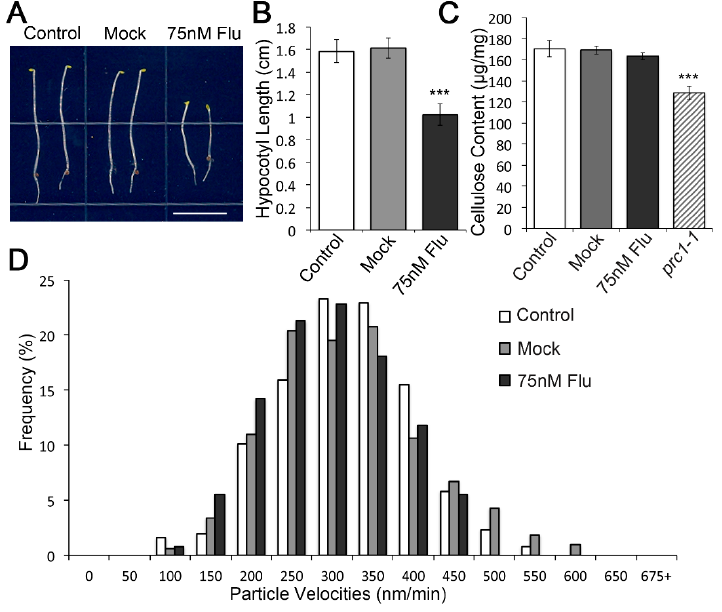
Figure 6. General VLCFA synthesis defect does not influence the functionality of the cellulose synthesis machinery. ( A ) Application of 75 nM Flu reduced the hypocotyl length of etiolated seedlings. 4-day-old dark-grown wild type (Col-0) seedlings grown on 1 / 2 MS medium (Control) or 1 / 2 MS medium containing 75 nM Flu or comparable amount of DMF (Mock). ( B ) Quantification of hypocotyl length of seedlings from the drug treatment analysis. *** p < 0.0001 ( n ≈ 50 per experimental group). ( C ) Crystalline cellulose production was not a ff ected following Flu treatment. Cellulose content of 3-day-old seedlings grown on 1 / 2 MS medium, 1 / 2 MS medium containing 75 nM Flu or comparable amount of DMF. Error bars represent SD. *** p < 0.0001. ( D ) A histogram showing the distribution of GFP-CESA3 particle velocities. The mean velocity of plasma membrane GFP-CESA3 for control, Mock and Flu groups were 319.59 ± 83.93 nm / min ( n = 258, 14 cells from 6 seedlings), 318.21 ± 92.41 nm / min ( n = 328, 16 cells from 7 seedlings) and 295.89 ± 79.00 ( n = 127, 8 cells from 5 seedlings),